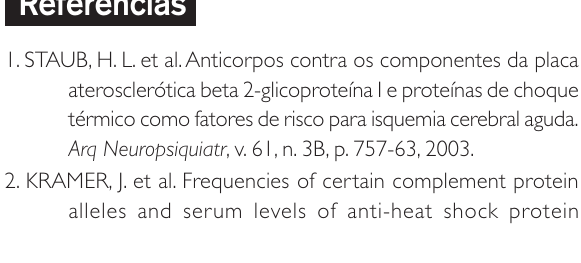
Chefe da Terapia Intensiva do Hospital Pró-Cardíaco; coordenador do Núcleo Gestor do Conheci- mento do CTI